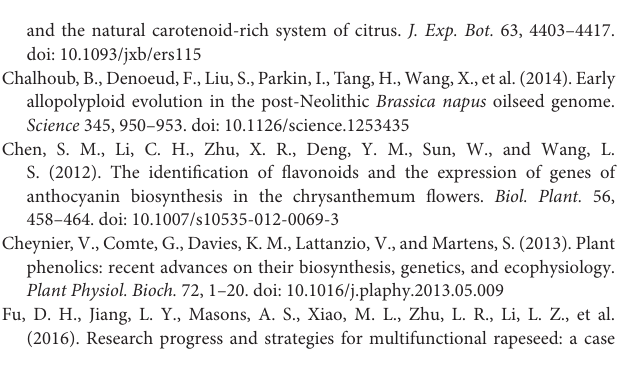
Supplementary Figure 1 | KEGG analysis of co-DEGs relative to red pigment formation. Supplementary Figure 2 | Heatmap of bHLH and MYB transcription factors among co-DEGs relative to red pigment formation. Supplementary Figure 3 | qRT-PCR identification of genes relative to anthocyanin biosynthesis. Supplementary Table 1 | Primers used in this research. Supplementary Table 2 | Basic results of RNA-seq